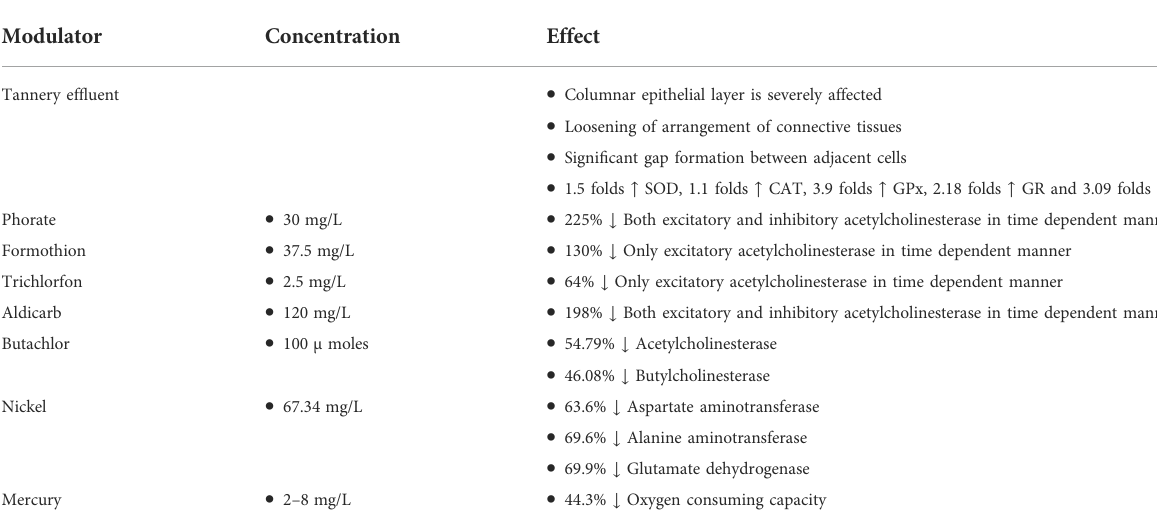
TABLE 1 Effects of different chemicals on physiology of P.